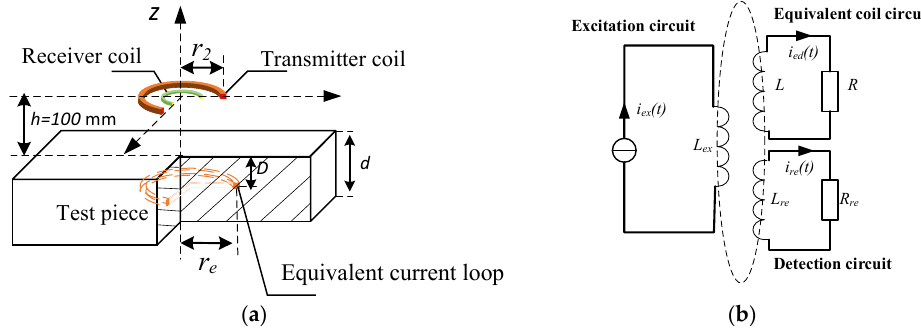
Figure 1. The coil-coupling model (CCM) of the PEC inspection. ( a ) The CCM applies an equivalent current loop with finite dimensions to approximate the general eddy current effect of the specimen. ( b ) The air-core transformer model, in which the primary side is the excitation circuit, and the secondary side is the equivalent current loop modeled by an inductor L and a resistor R in series connection.